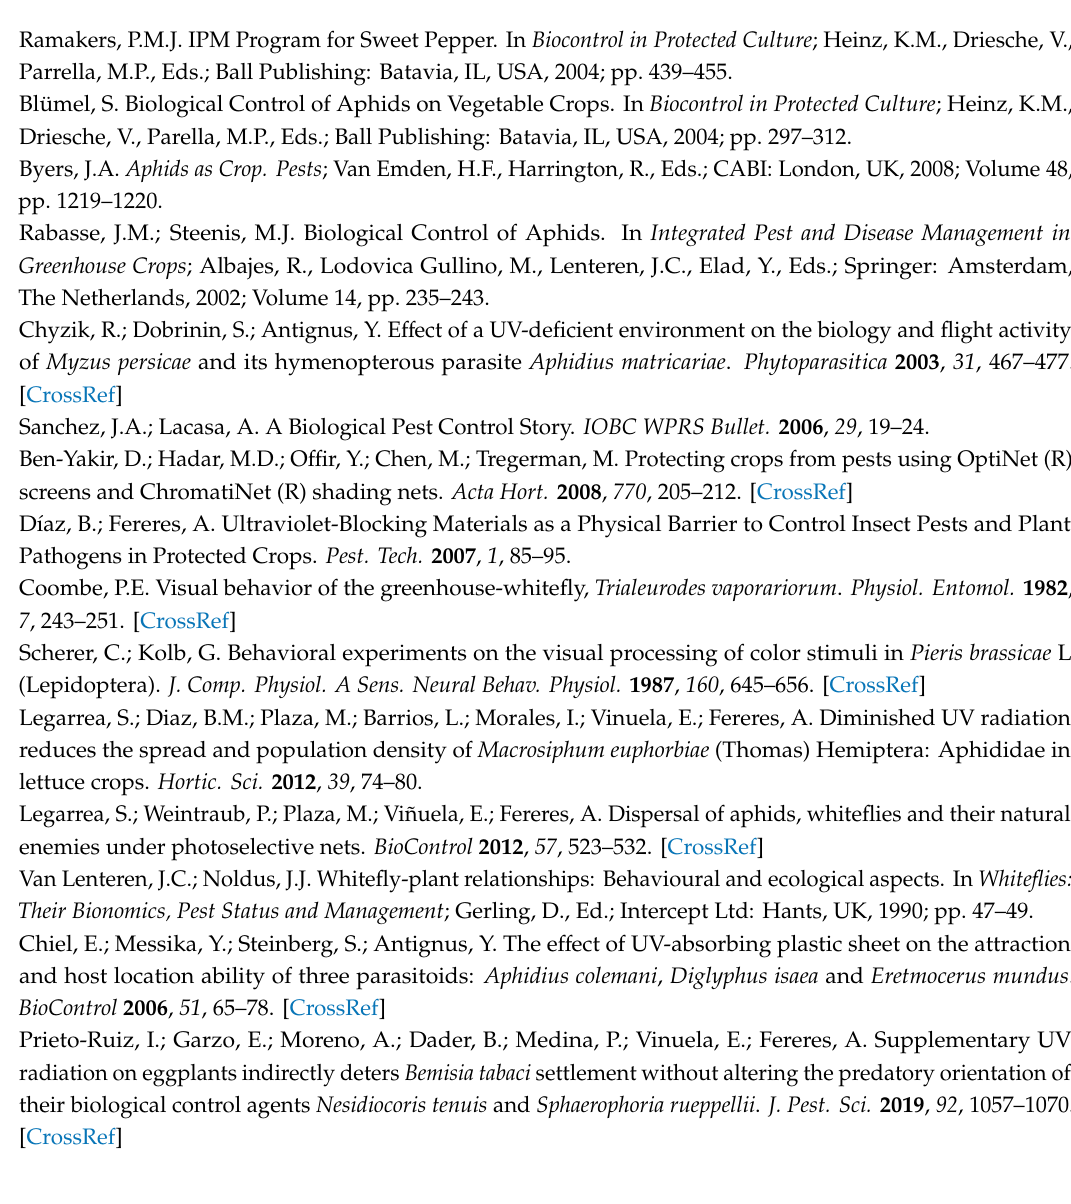
Table S1: Percentage of UV radiation transmitted under each type of net (mean ± SE). Di ff erent letters